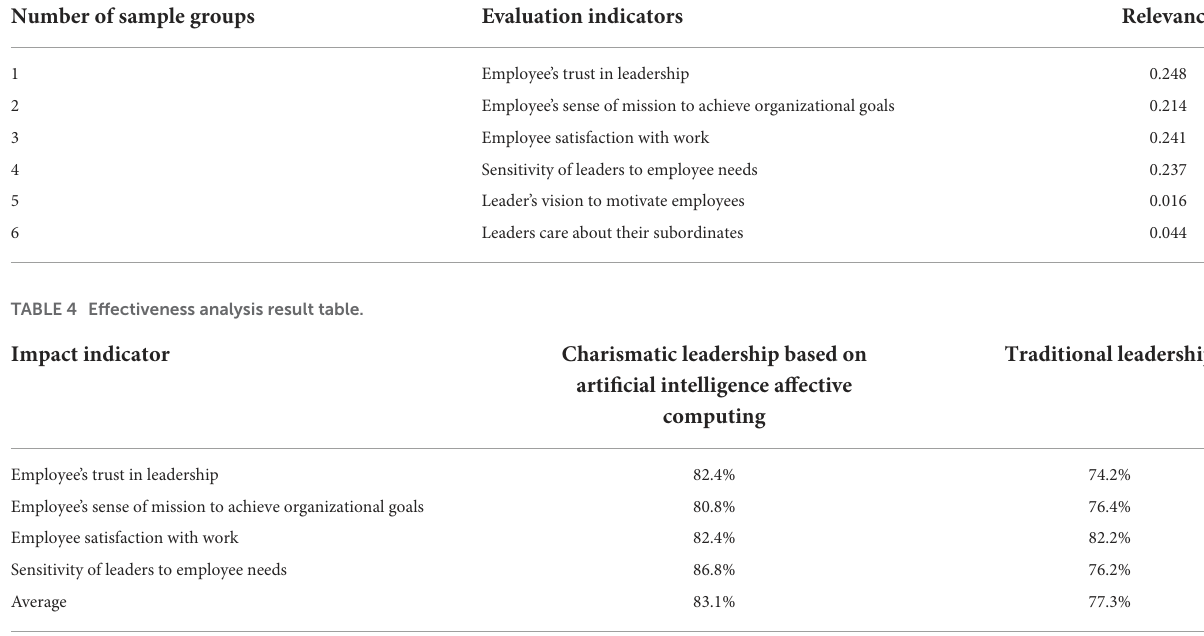
TABLE 3 Correlation analysis of the psychological state prediction analysis of leaders’ attitude toward employees’ work.